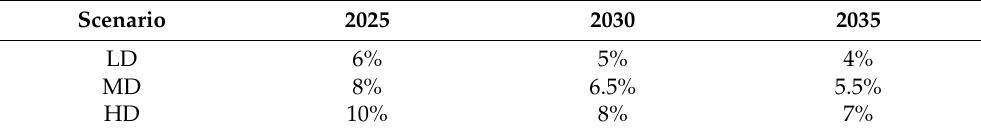
Table 5. Growth rate of industrial fixed asset investment in Shandong Province from 2020 to